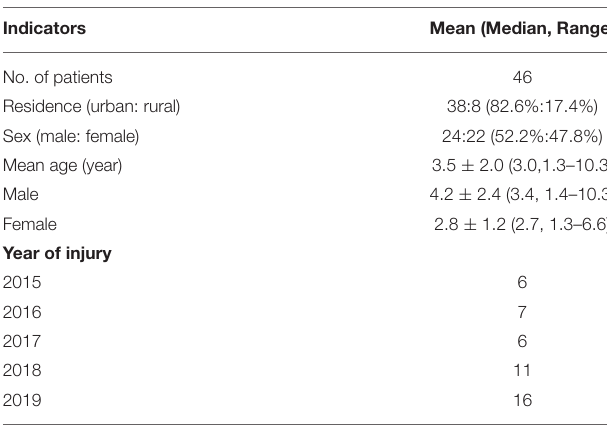
TABLE 1 | Patients’ demographic and injury